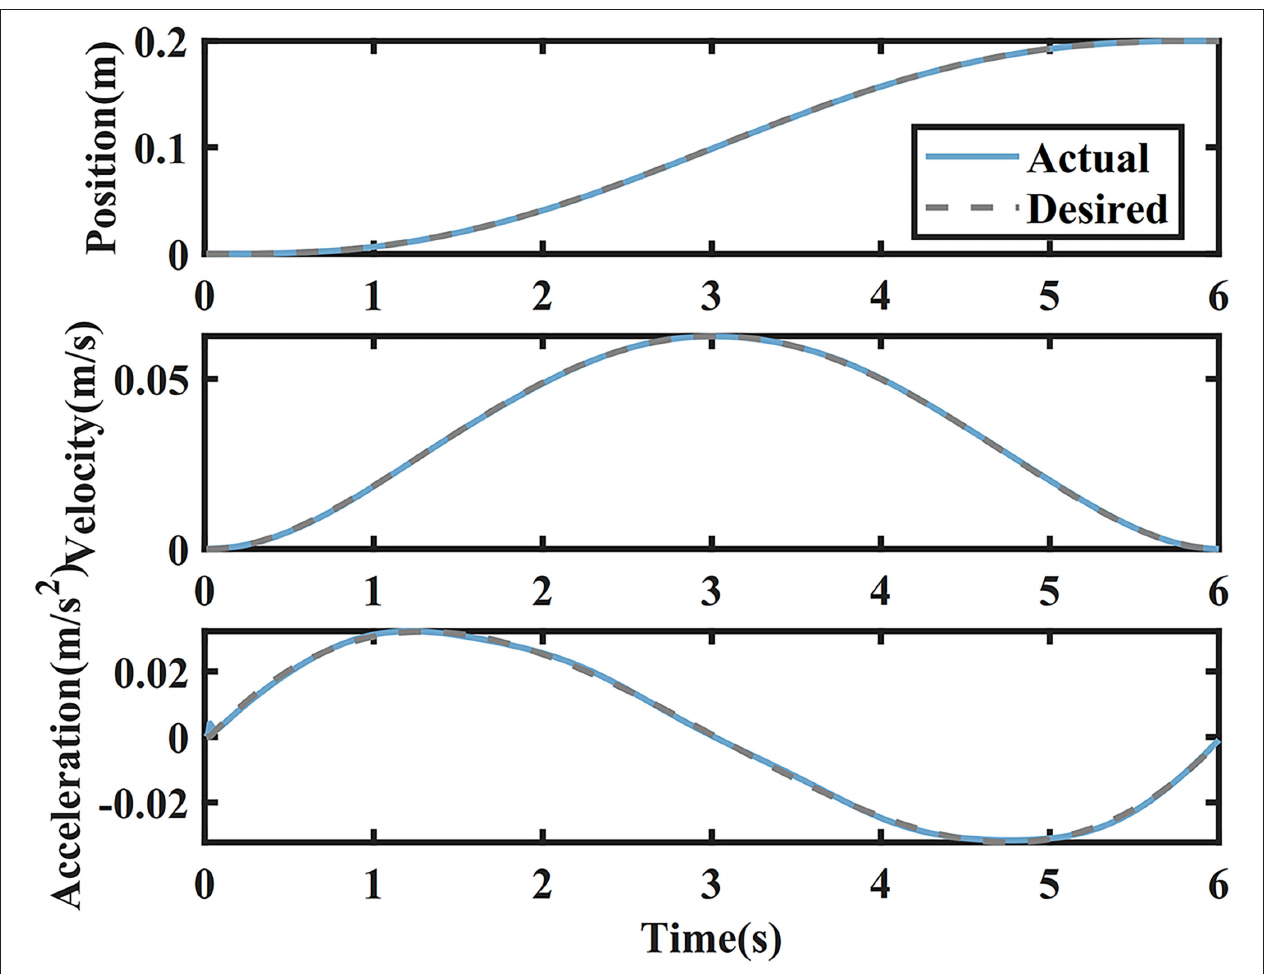
FIGURE 4 | The desired and actual values of the trajectory, velocity, and acceleration of the impedance control with high constant damping (IC-H) in the main motion